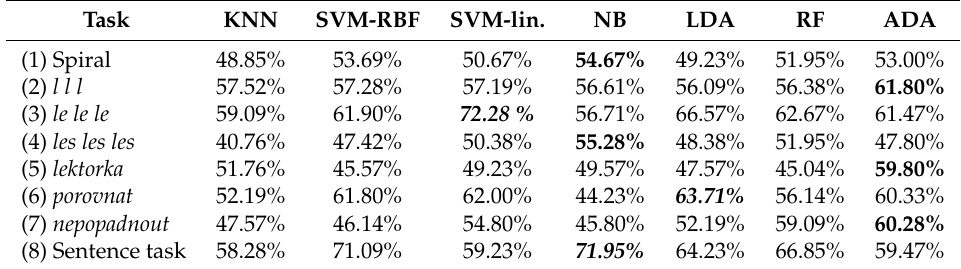
Table 5. Accuracy performance task by task. The best results per task are in bold; the best three tasks overall are in italics.